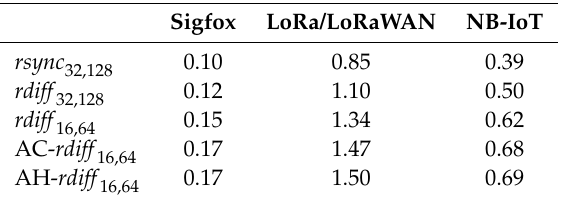
Figure 9. Power consumption, measured in milliwatt second, of a single synchronization procedure considering different LPWAN technologies and algorithms. Table 4. Device battery lifetime, measured in years, considering the scenario where the 3 kB file synchronization is performed once every 24 h. Results are shown as a function of the LPWAN technology and file synchronization